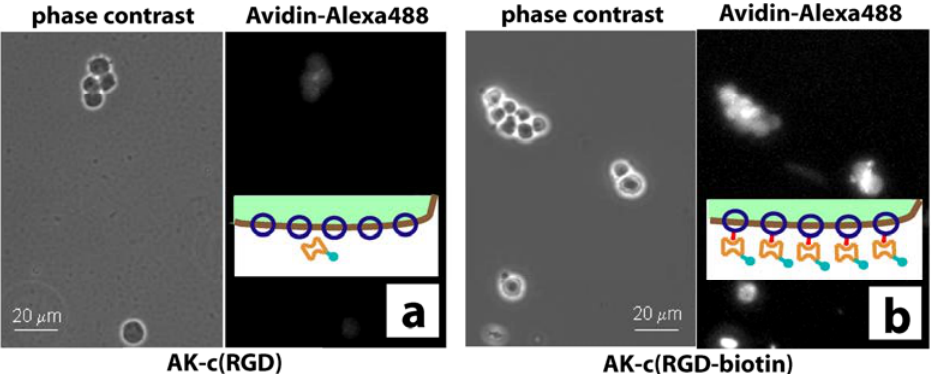
Figure 4. Phase-contrast and fluorescence microscopy (FM). ( a ) Neural stem cells are imaged by phase-contrast microscopy. Cells are first exposed to non-biotinylated AK-cyclo[RGDfC] peptides, and secondly to fluorescently labeled avidin, and finally imaged by FM. ( b ) Cell exposure to biotinylated AK-cyclo[RGDfC] enhances avidin absorption to cells. The insets illustrate the surface of a cell decorated with AK-cyclo[RGDfC] (shown in blue) or the biotinylated AK-cyclo[RGDfC] (shown in blue with red bars) and the binding to fluorescently labeled avidin (shown in orange, label shown in